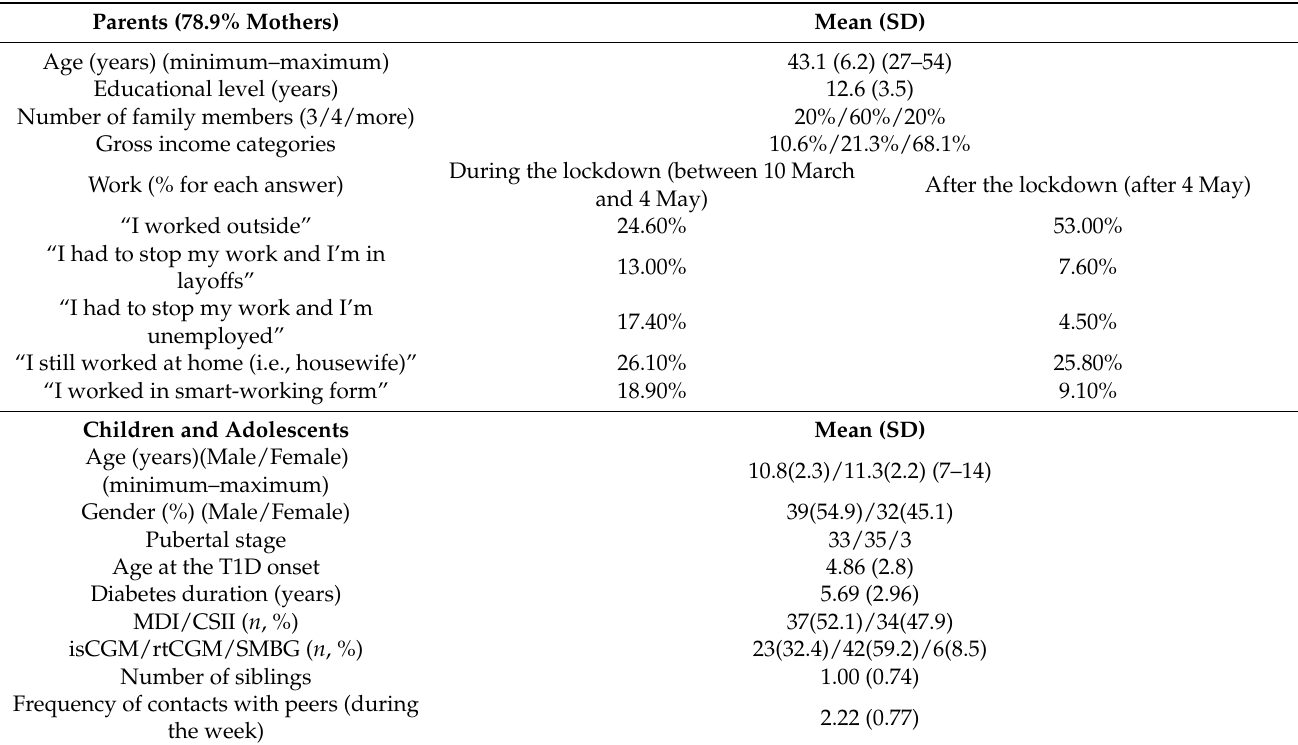
Table 1. Demographics and descriptive information of parents and children.